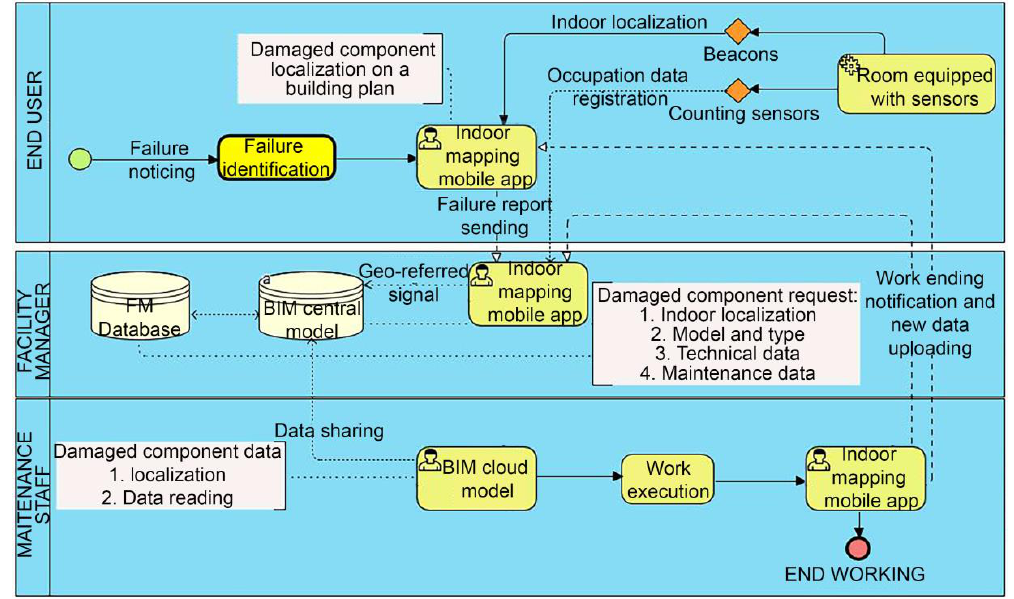
Figure 5. Indoor localization system: process flowchart.